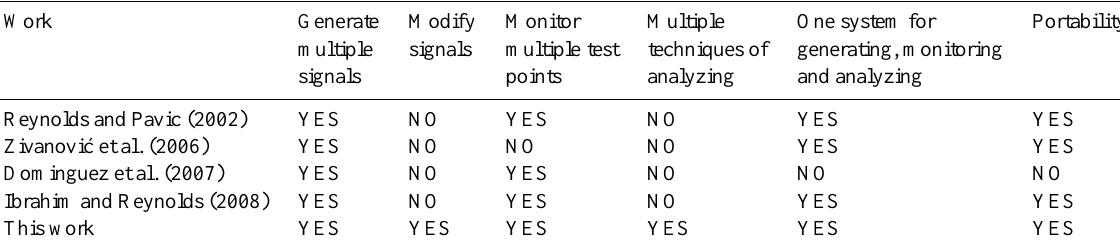
Table 1. Features comparison between the proposal and reported